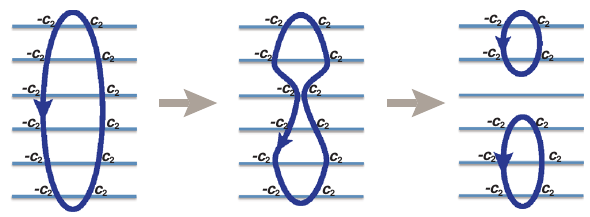
FIG. 11. One c string can be deformed and split into two c strings through the fusion of c 2 ’ s within the layers. The reverse process can be viewed as the fusion between two c